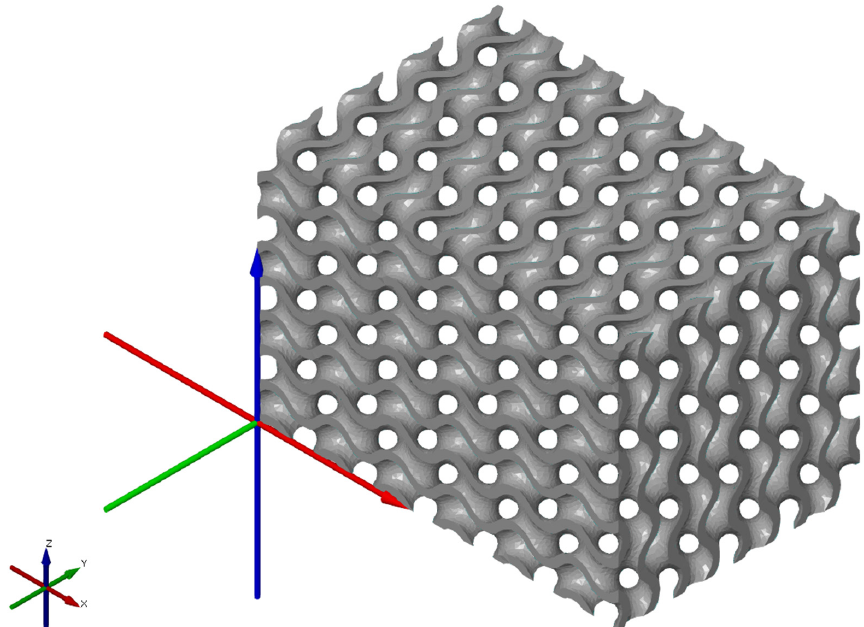
Figure 14. The resulting cellular structure model suitable for the preparation of the physical model manufacturing process using FDM technology.